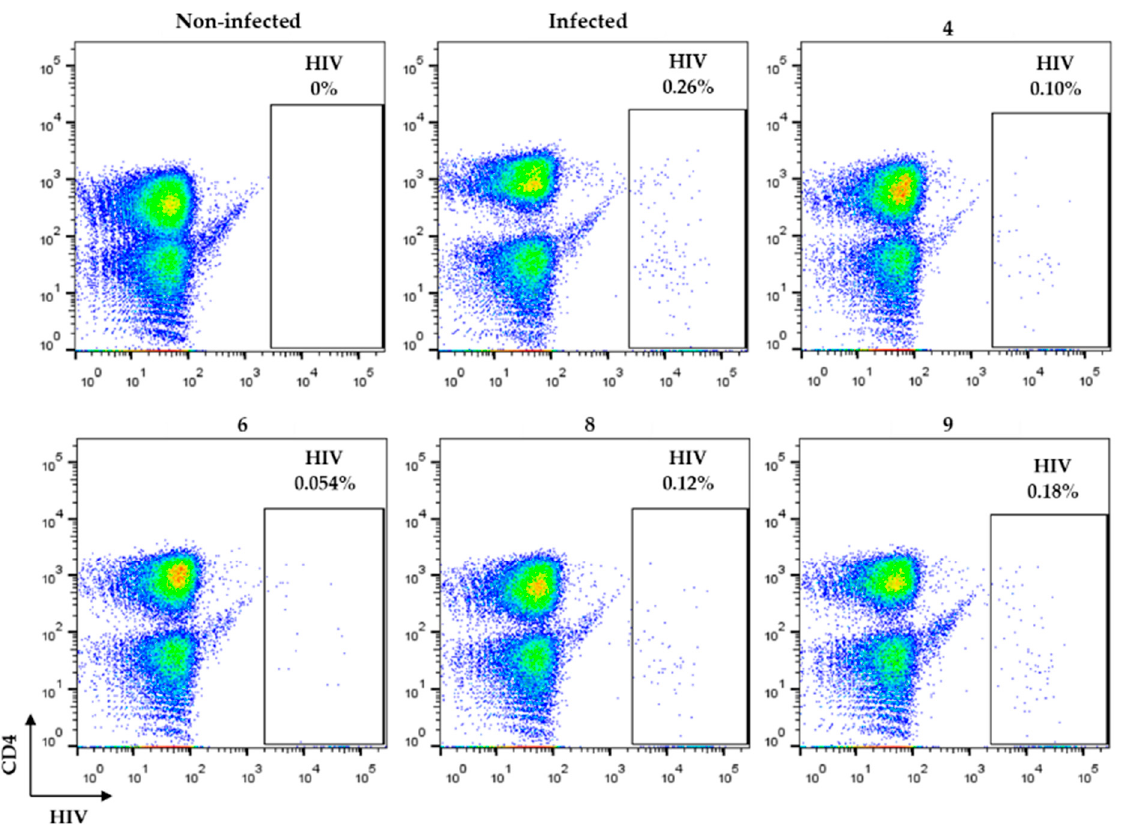
Figure 7. Frequency of HIV-1 infected primary CD4 + T cells treated with AZT-derivatives before infection. Dot plots illustrating primary T cells HIV-1 infection levels in primary CD4 + T cells either left untreated (infected) or treated post with AZT-derivatives (Infected + compound).